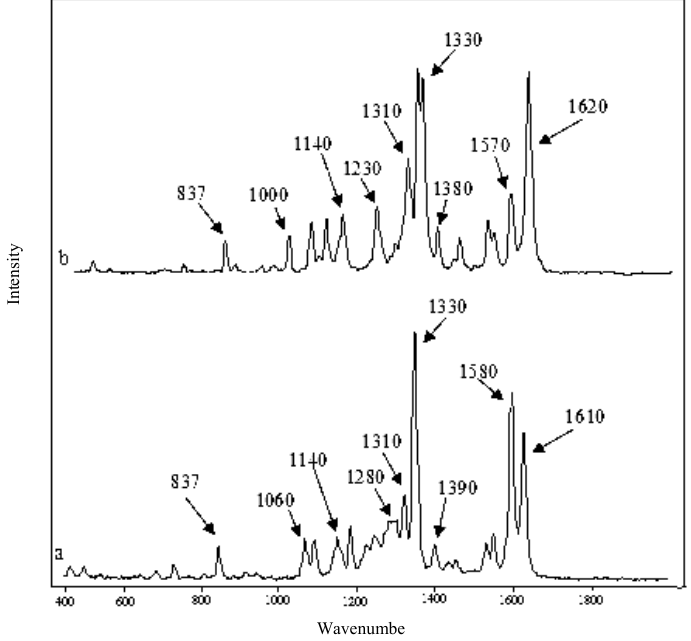
Figure 1. Raman spectra of (a) [Hg(L 1 )